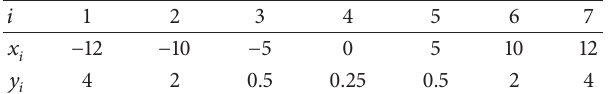
Table 1: 2D convex data